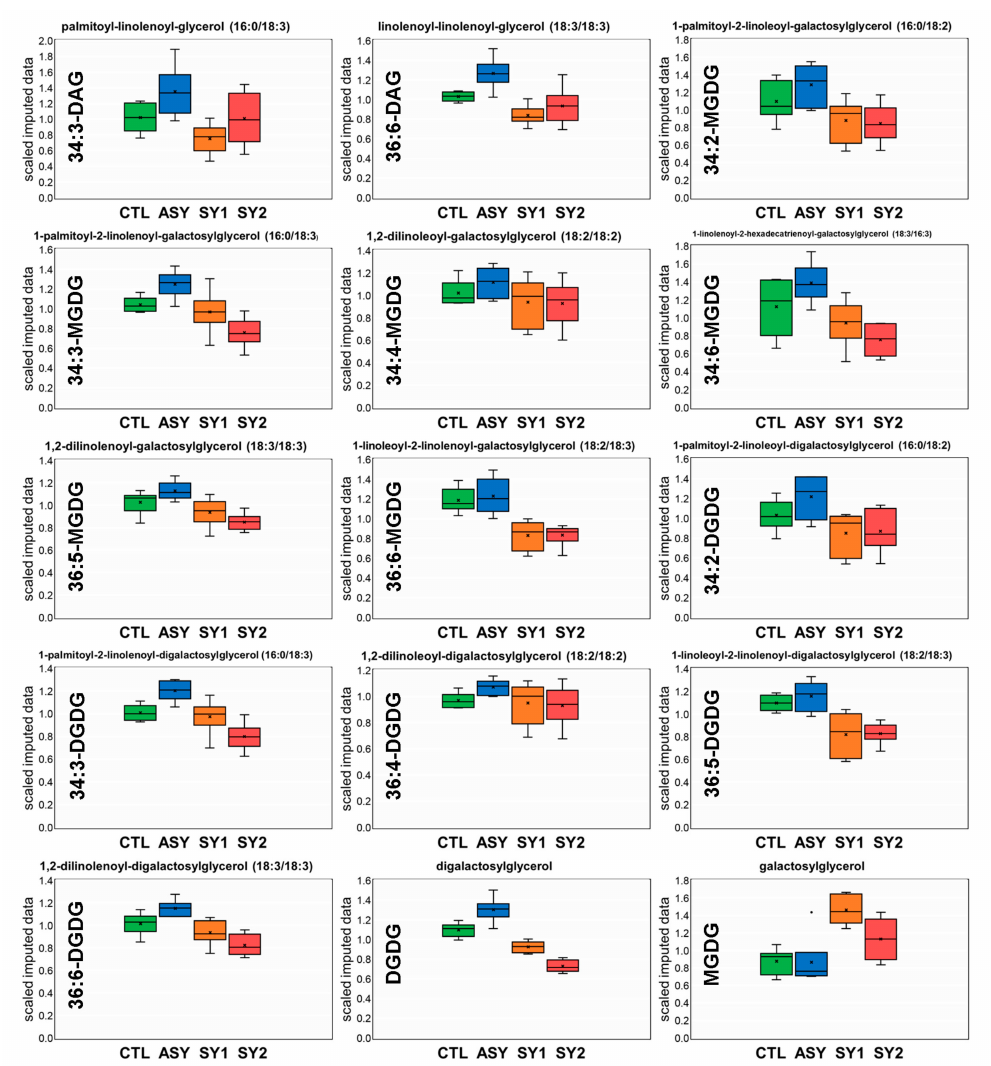
Figure 7. Galactolipid and diacylglycerolipid profiles (names on the top and abbreviations on the Y -axis) of leaves of Vitis vinifera L. ‘Malvasia Fina’ a ff ected by Esca complex disease (ESCA). Levels of individual lipid species are expressed as scaled imputed data, as detailed in the Materials and Methods Section. CTL = healthy leaves from healthy una ff ected control vines, ASY = healthy leaves from foliar-asymptomatic and wood-symptomatic vines, SY1 = chlorotic leaves from foliar-symptomatic and wood-symptomatic vines, SY2 = spotted / scorched leaves from foliar-symptomatic and wood-symptomatic